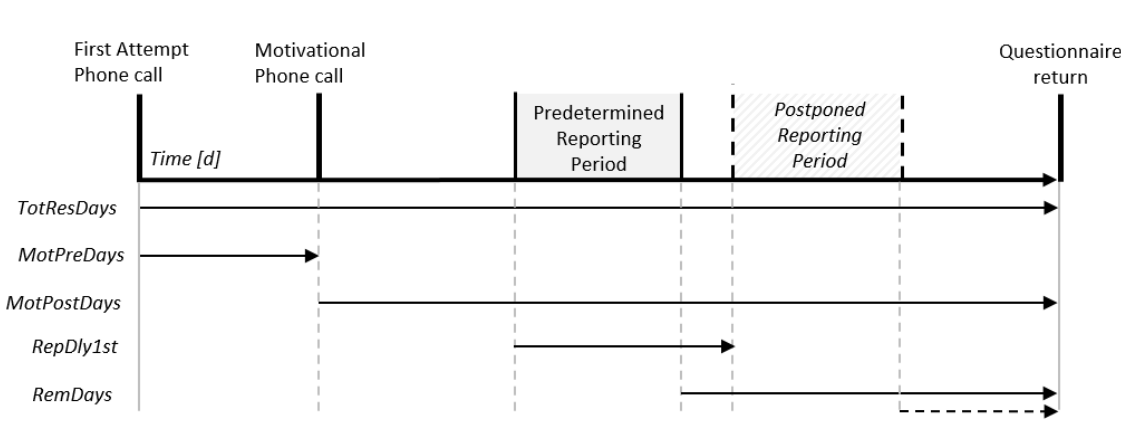
Figure 2. Response variables describing response durations in different phases of both